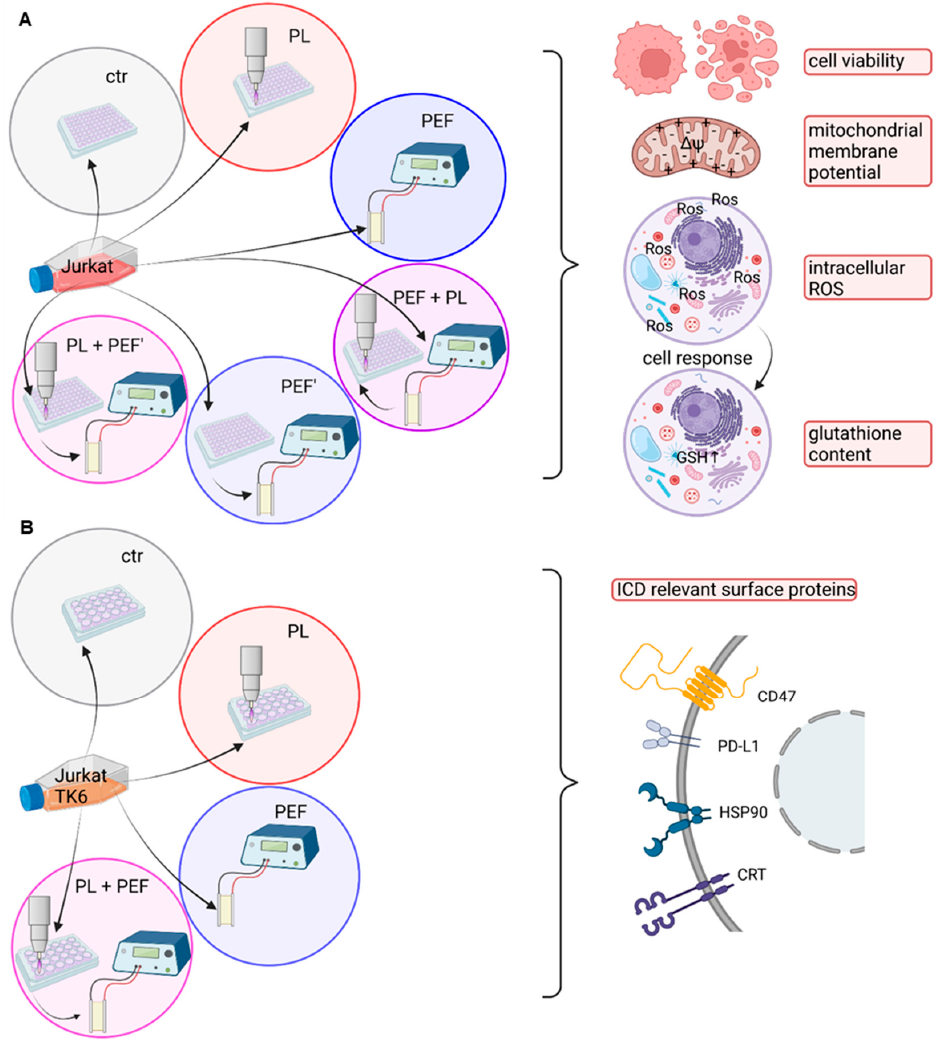
Figure 1. Experimental plasma and PEF combination set up in 96- or 24-well plate. Jurkat cells were utilized to determine the cell viability, mitochondrial membrane potential, intracellular ROS, and glutathione content. The experiments were performed in DMEM and 96-well plates. The sequence order of plasma first and PEF second and vice versa were investigated ( A ). For the ICD analysis, Jurkat and TK6 cells were seeded in a 24-well plate in RPMI. The ICD-relevant surface proteins, CD47, PD-L1, HSP90, and CRT, were measured via flow cytometry. In the combination, the treatment order of plasma first and PEF second was examined ( B ). ctr: control; PL: plasma; PEF: pulsed electric fields; PEF’: cells were seeded into 96 well plates before being transferred into cuvettes; ∆Ψ : mitochondrial membrane potential; ROS: reactive oxygen species; GSH: glutathione; CD47: cluster of differentiation 47; PD-L1: programmed cell death ligand 1; HSP90: heat shock protein 90; CRT: calreticulin; ICD: immunogenic cell